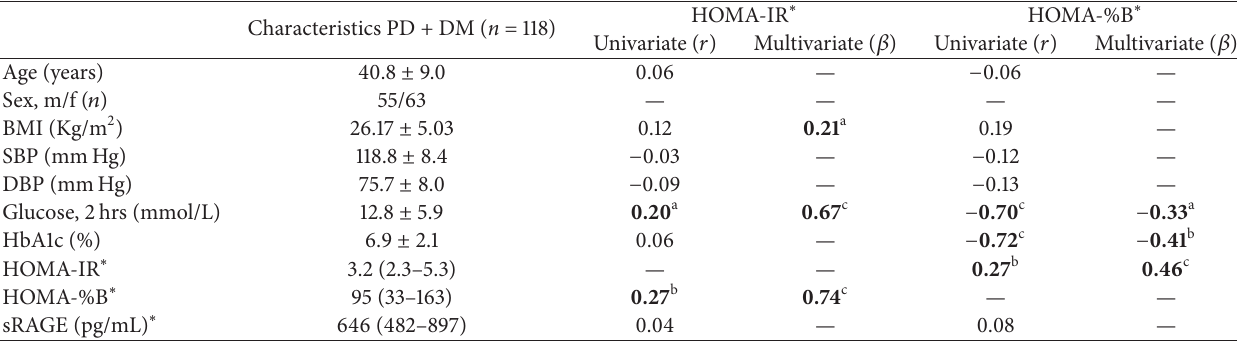
Table 2: Patient characteristics and associations of HOMA-IR and HOMA-%B with different variables in people with prediabetes and newly diagnosed type 2